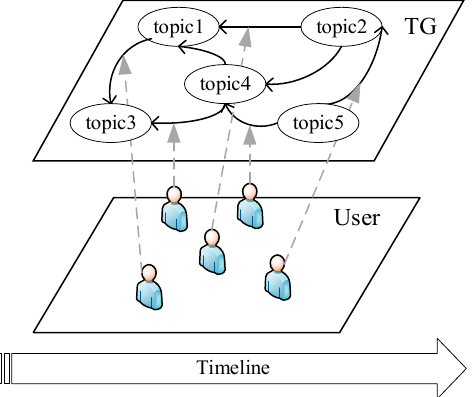
Figure 3. The structure of the semantic change network.